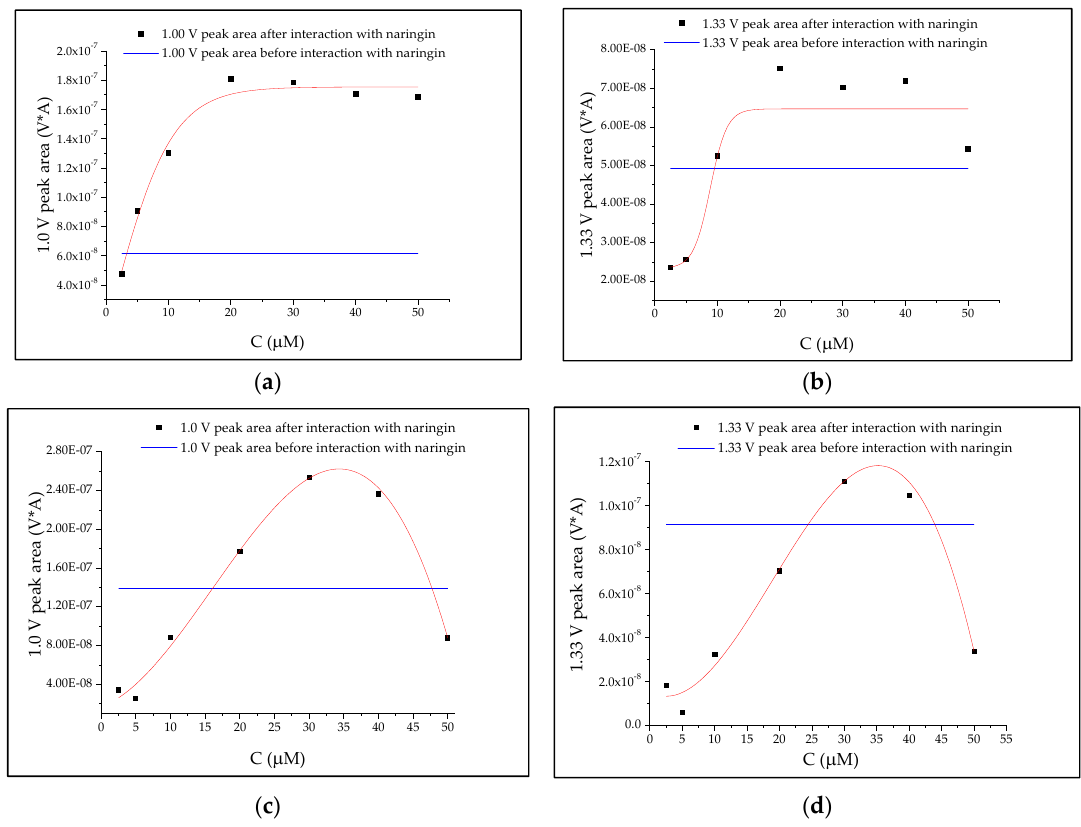
Figure 4. The relation between the areas of oligonucleotide ( a, b ) and dsDNA ( c, d ) peaks at +1.0 V ( a, c ) and +1.3 V ( b, d ) and the concentration of naringin.